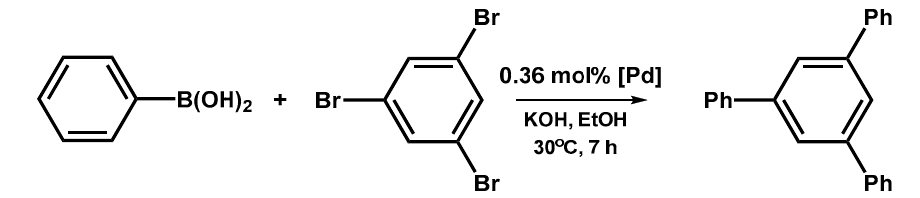
Table 2. The average size of PdNPs before and after Suzuki